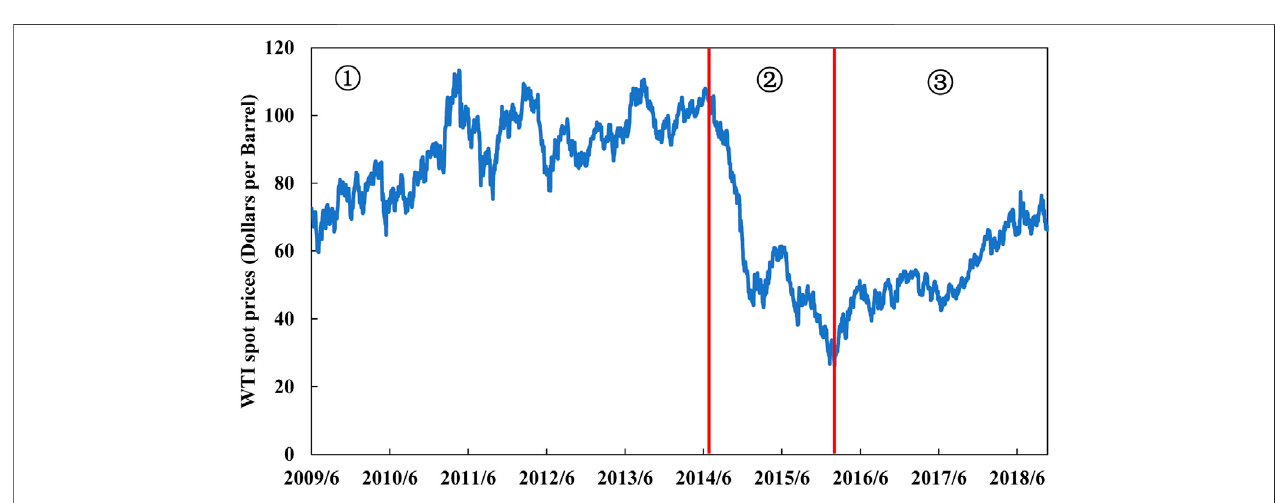
FIGURE 5 | Trend of WTI